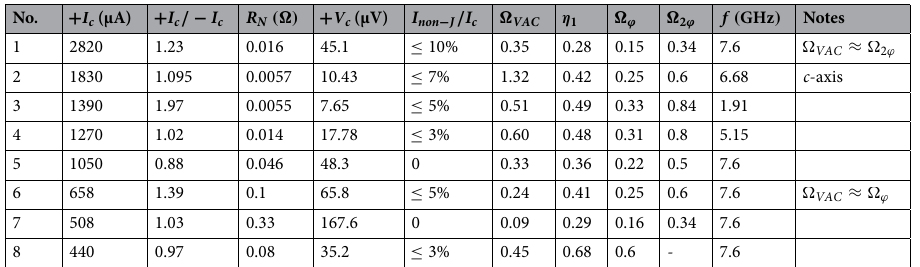
Table 1. Summary of the main characteristics of the point-contact Josephson junctions studied in this work. I c is the critical current of the contact, R N its resistance, determined from the low-voltage part of I − V curve, V c = I c R N is the characteristic voltage of the junction, I non I c is the percentage of the superconducting non- − J / Josephson current, (cid:31) VAC the normalized frequency of the microwave radiation as determined directly from the current-voltage characteristic. η 1 , � ϕ and � 2 ϕ , which are shown in Fig. 6, are the normalized oscillation period of the first current step and the normalized frequencies of the microwave radiation, found from the oscillation periods of the first current steps for the two different I s (ϕ) relationships, respectively. For contact No. 8 there is no intersection between η 1 and � 2 φ .